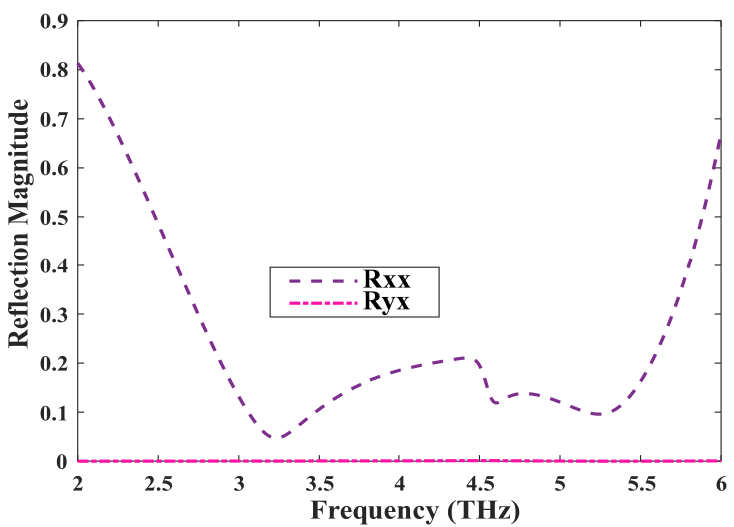
Figure 2. Magnitude of reflection coefficients of the design structure when conductivity of metal is σ = 2 × 10 5 S/m.